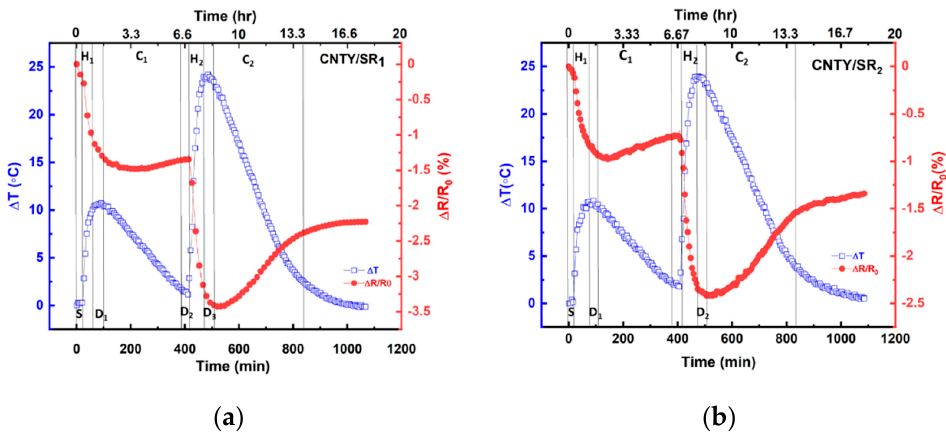
Figure 6. Temperature change and fractional change in electrical resistance during heating/cooling cycles of: ( a ) CNTY/SR 1 ; ( b ) CNTY/SR 2 .